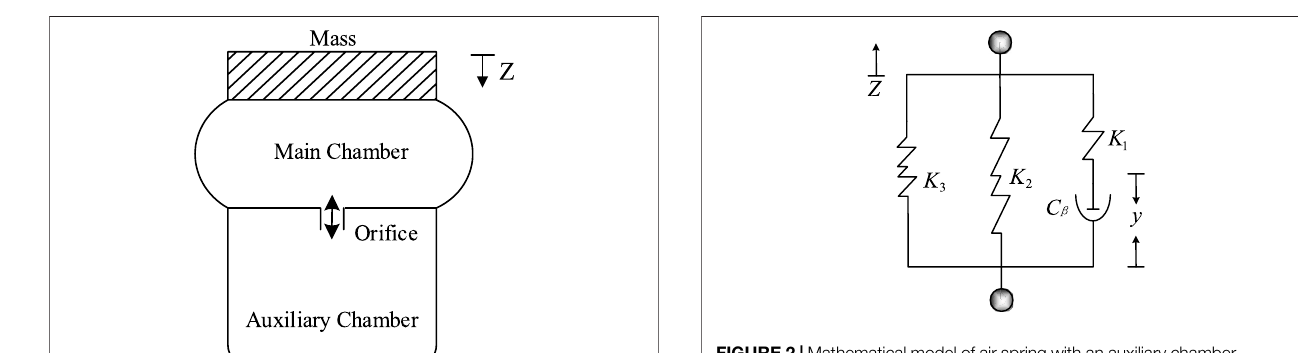
FIGURE 2 | Mathematical model of air spring with an auxiliary